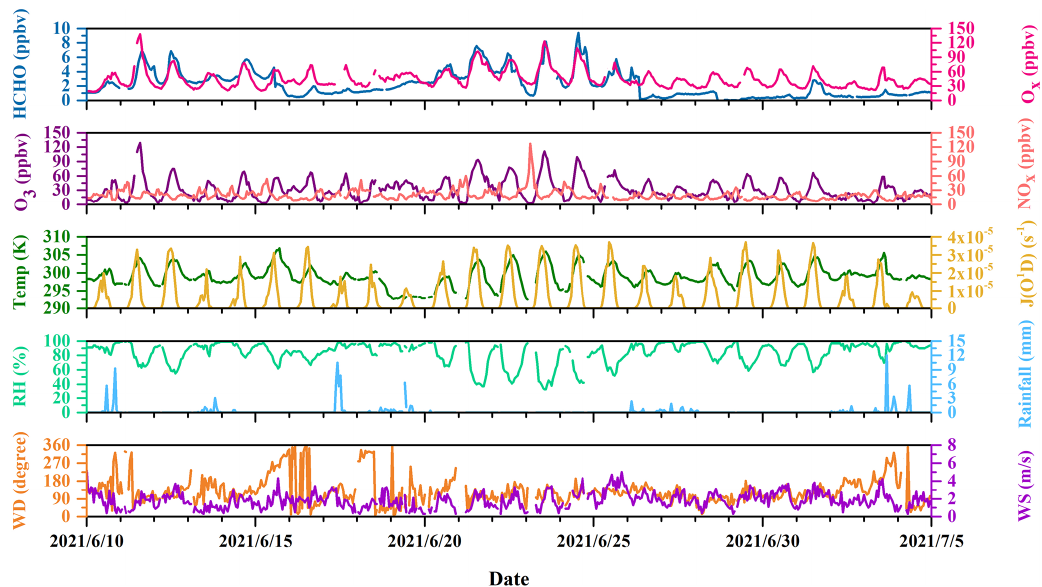
Figure 2. Time profiles of HCHO, O x ( = NO 2 + O 3 ), O 3 , and NO x ; photolysis frequencies of O 1 D ( J (O 1 D)); and meteorological parame- ters during the